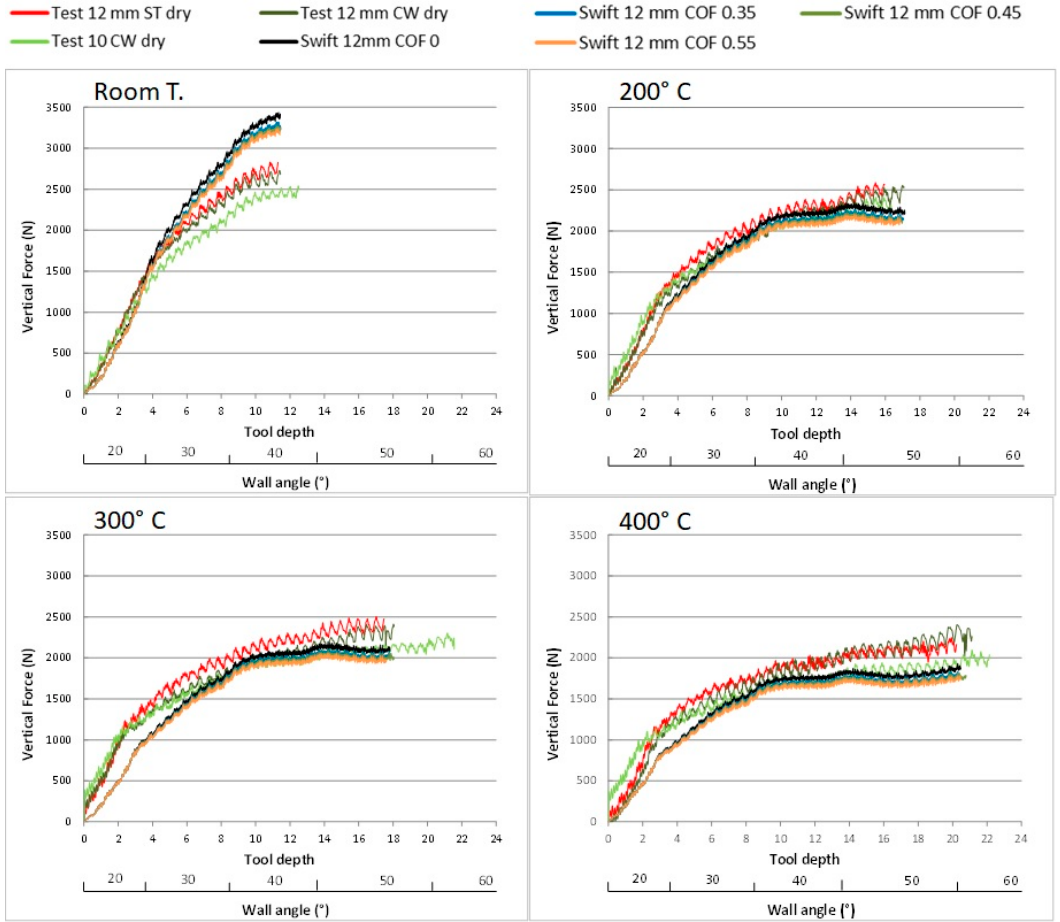
Figure 10. Experimental and simulated forces on the Z-axis for assays at different temperatures.